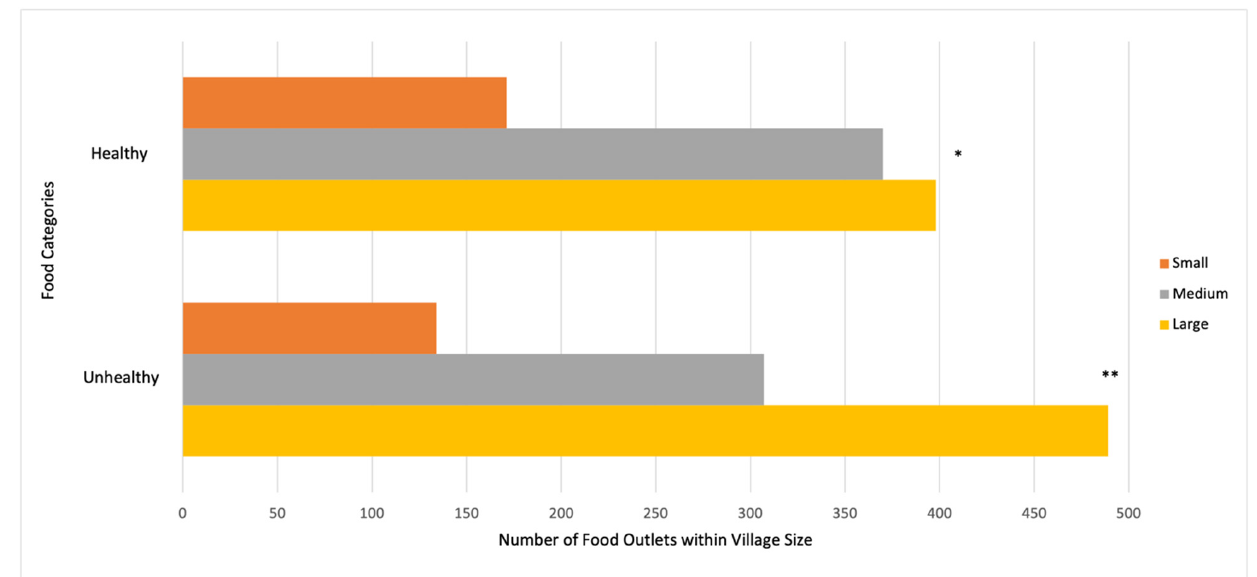
Figure 2. Availability of Healthy and Unhealthy Food by Total Number of Food Outlets in Villages. Healthy food consists of availability of fruits, vegetables, roots and tubers, legumes and nuts, eggs, milk, water, fish and seafood, and flesh and organ meat. Unhealthy food consists of ultra-processed food such as sweetened soda or sweetened juice drinks, sugary foods such as chocolates, candies, cookies, cakes, and chips, and street and fast foods. χ 2 test * = p < 0.05; ** = p < 0.001.